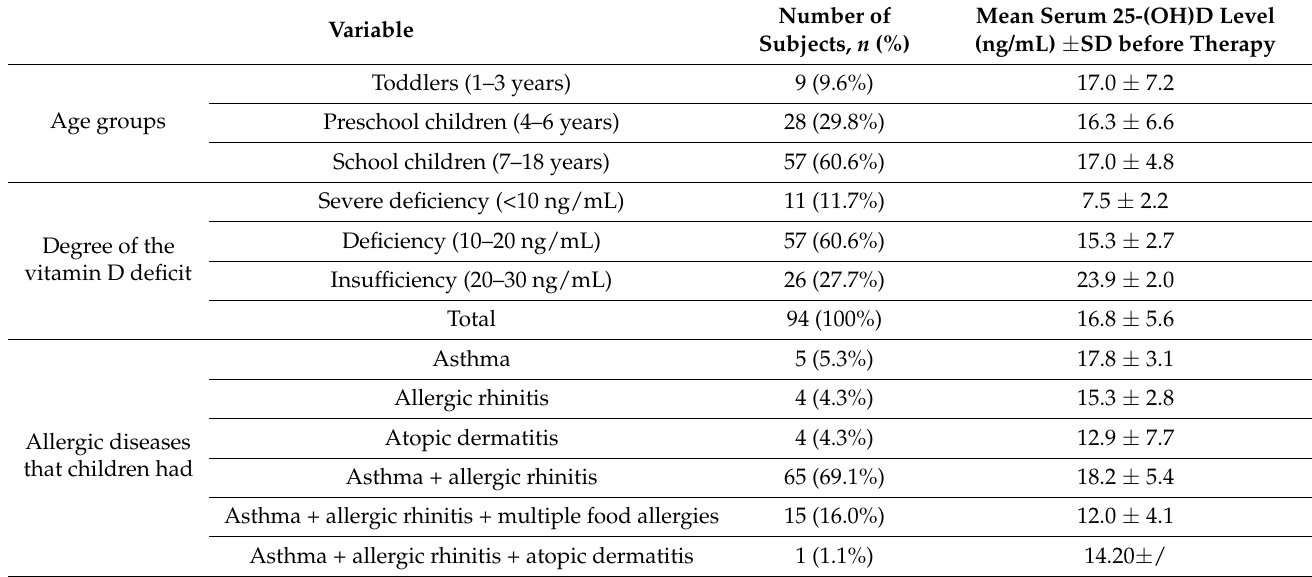
Table 1. Baseline serum levels of 25-(OH)D before vitamin D3